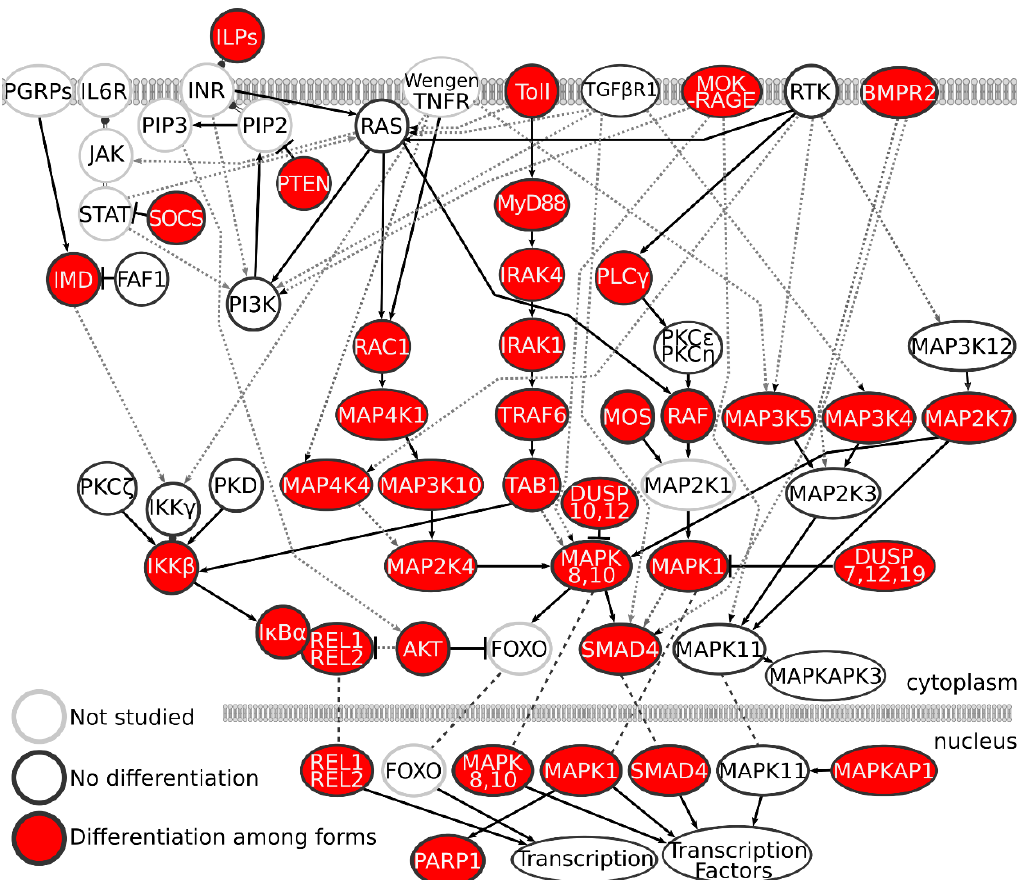
Table 2. Distribution of SNP genotypes among potentially functional SNPs. Results support the hypothesis that these are under significant selection among taxa (α < 0.05). Numbers indicated number of individuals observed per genotype.